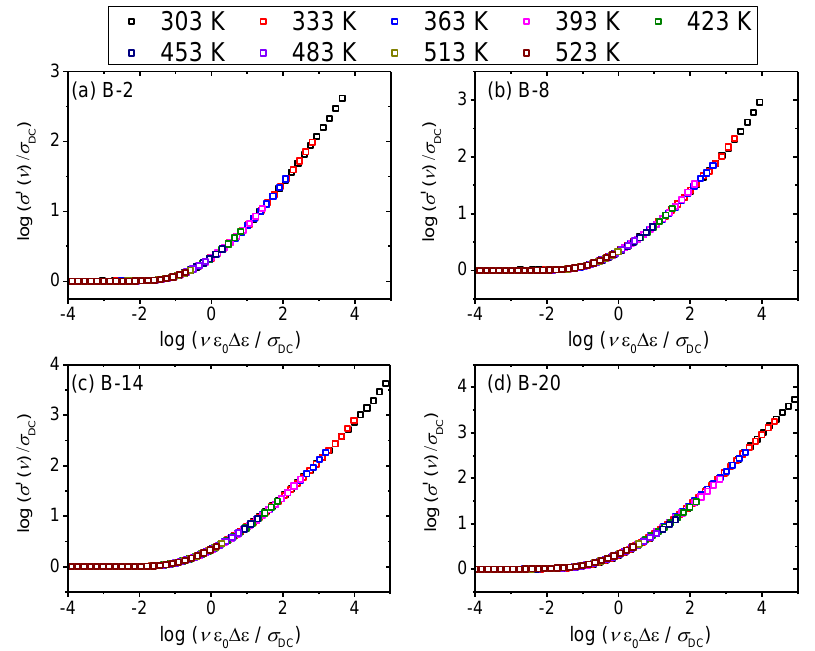
Figure 9. Conductivity spectra scaled according to the Sidebottom scaling procedure for ( a ) B-2, ( b ) B-8, ( c ) B-14 and ( d ) B-20 glasses.